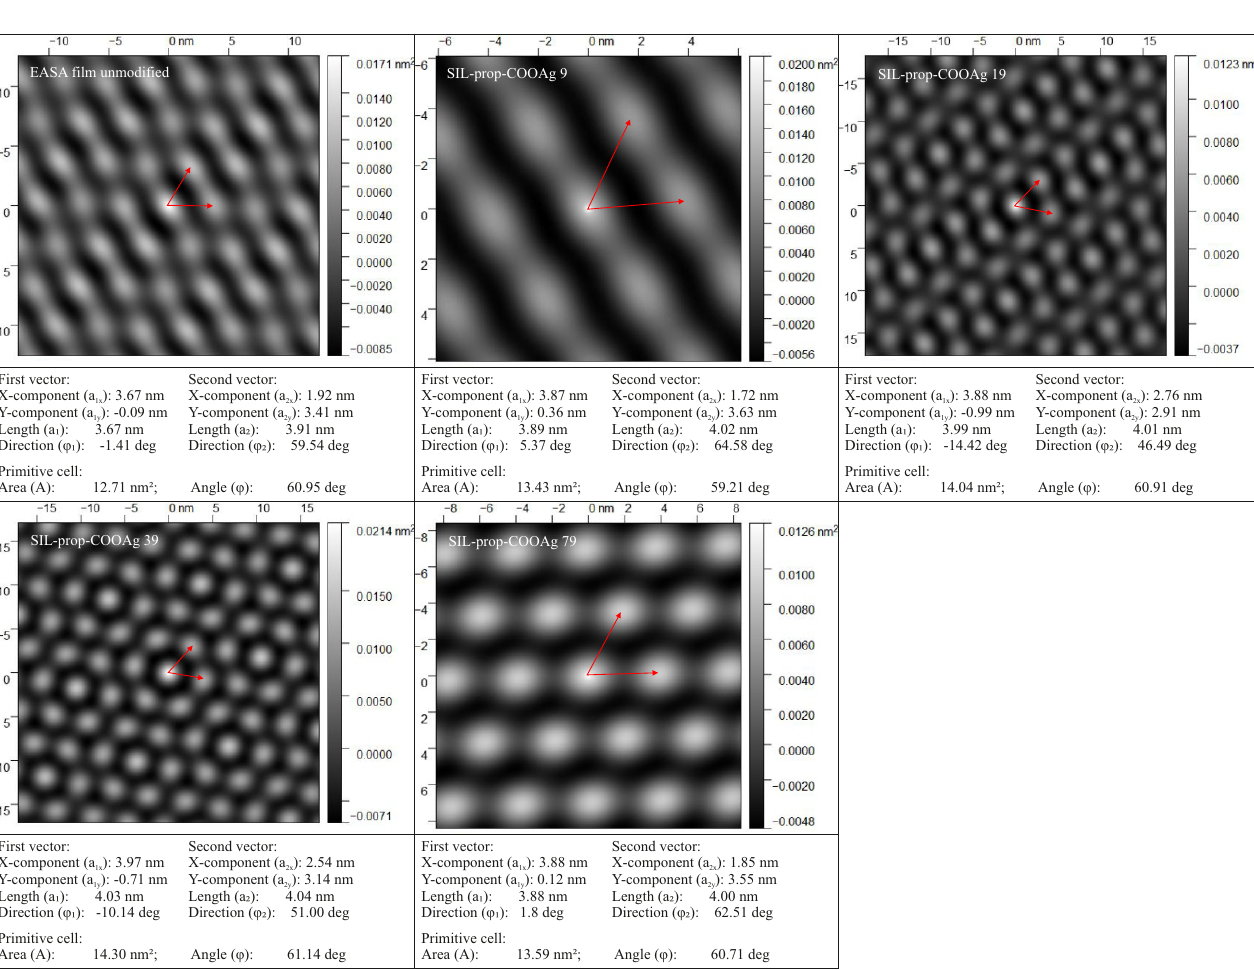
Figure 5. ACF processing of TEM images of investigated materials juxtaposed with unmodified thin silica film. Samples with marked elemental cell vectors, along with pore distribution